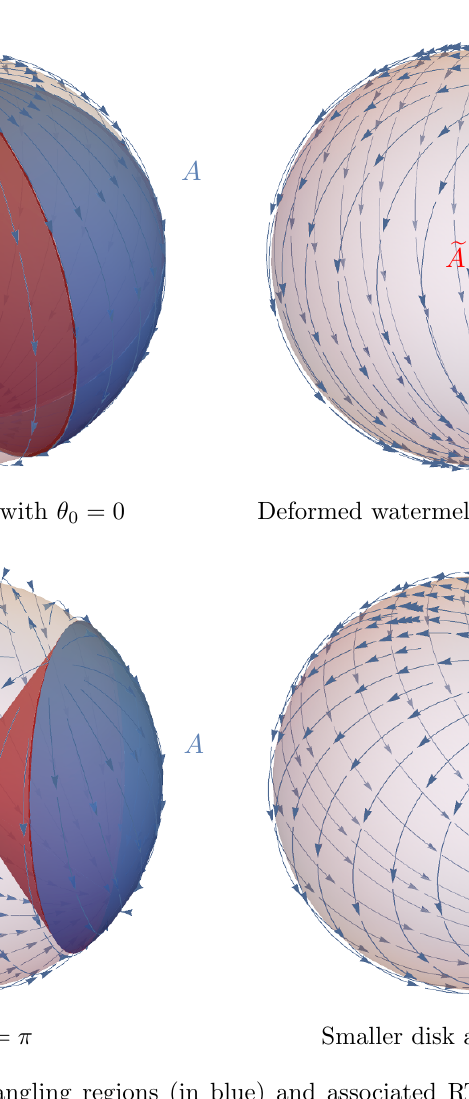
Figure 5 . Examples of entangling regions (in blue) and associated RT surfaces (in red) for 4d Minkowski on the constant u = 0 slice. They are associated to the modular (cid:13)ow (6.10) and its bulk extension